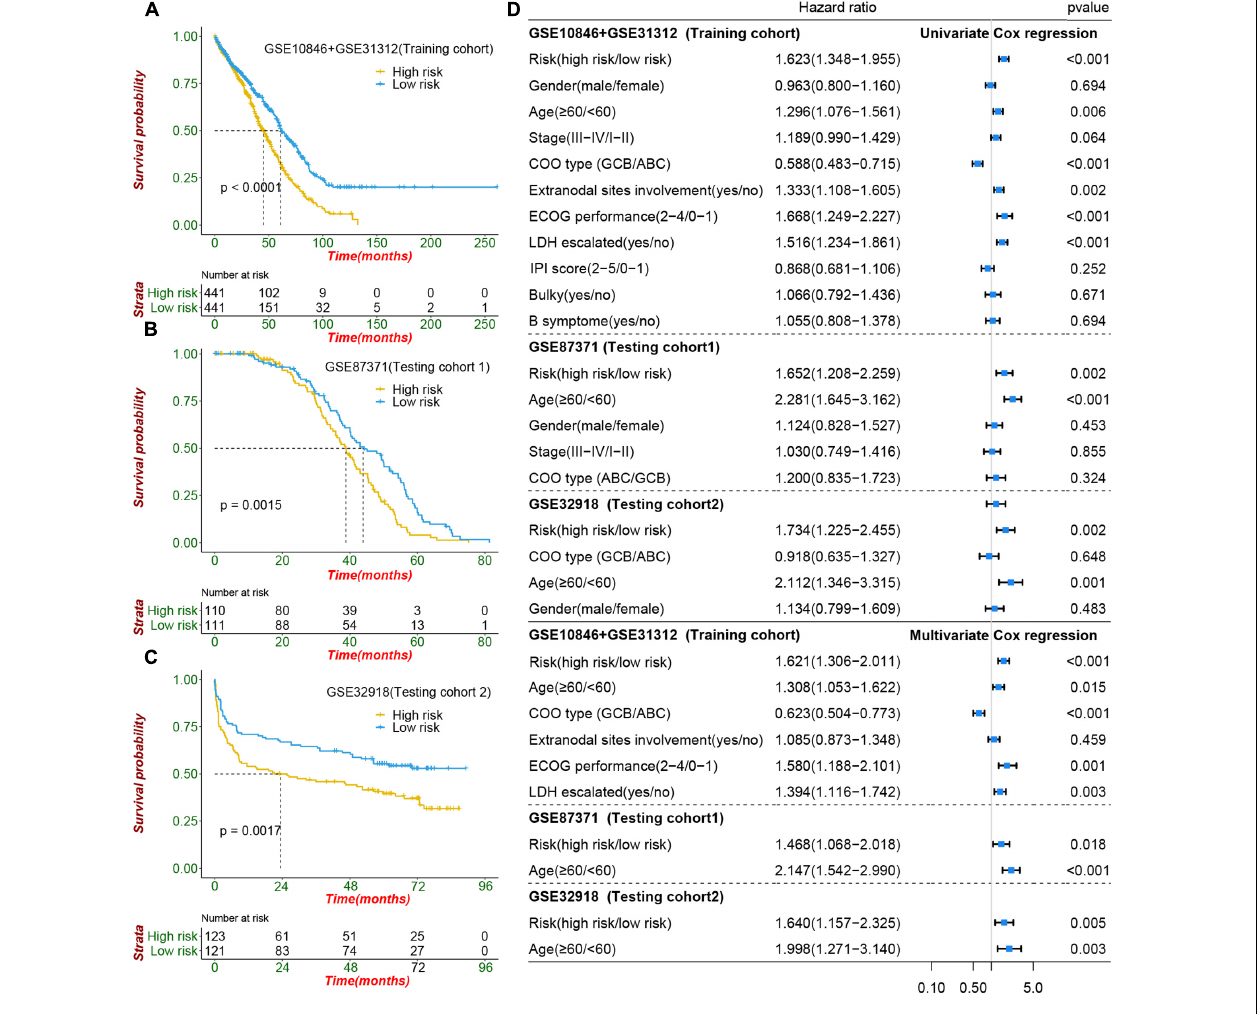
FIGURE 5 | Prognostic value of cachexia-inducing factor (CIF) risk signature in patients with DIBCL. (A–C) Performance of the CIFs based on the risk signature in predicting overall survival in the training cohort and two independent testing cohorts. (D) Forest plot showing that the signature is significantly associated with prognosis and works independently of the cell of origin subtyping and all clinical features in univariate CoxPH and multivariate CoxPH